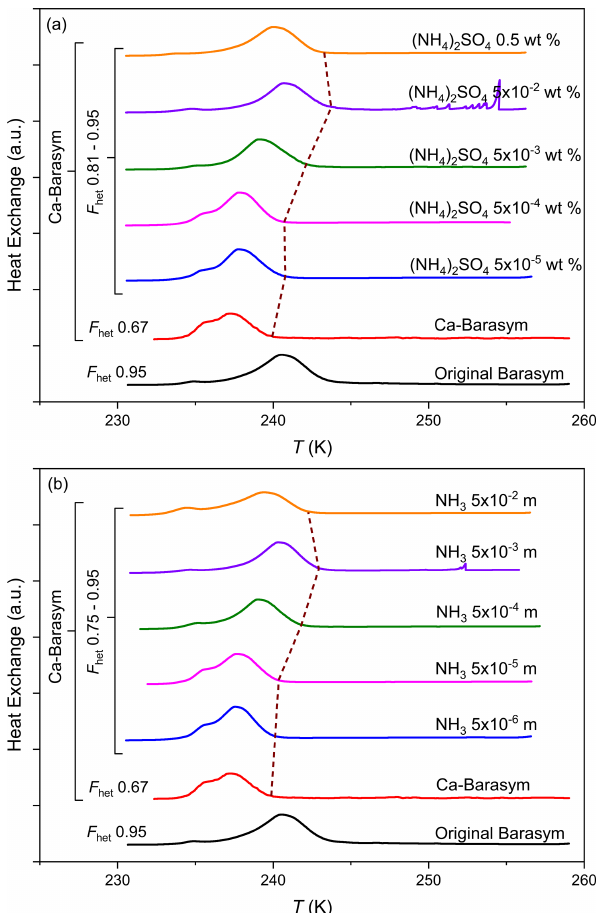
Figure 2. DSC thermograms obtained via emulsion freezing ex- periments with Barasym in pure water (original Barasym) com- pared with the ion exchanged Ca-Barasym in pure water and in (a) ammonium sulfate solutions (inwt%) and (b) ammonia solu- tions (in molality) with increasing concentration as indicated on the DSC curves. The concentration of Barasym in the suspensions was 0.5wt%. The dashed brown line indicates the freezing onsets. All curves are normalized with respect to the total areas under the het- erogeneous and homogeneous freezing curves.